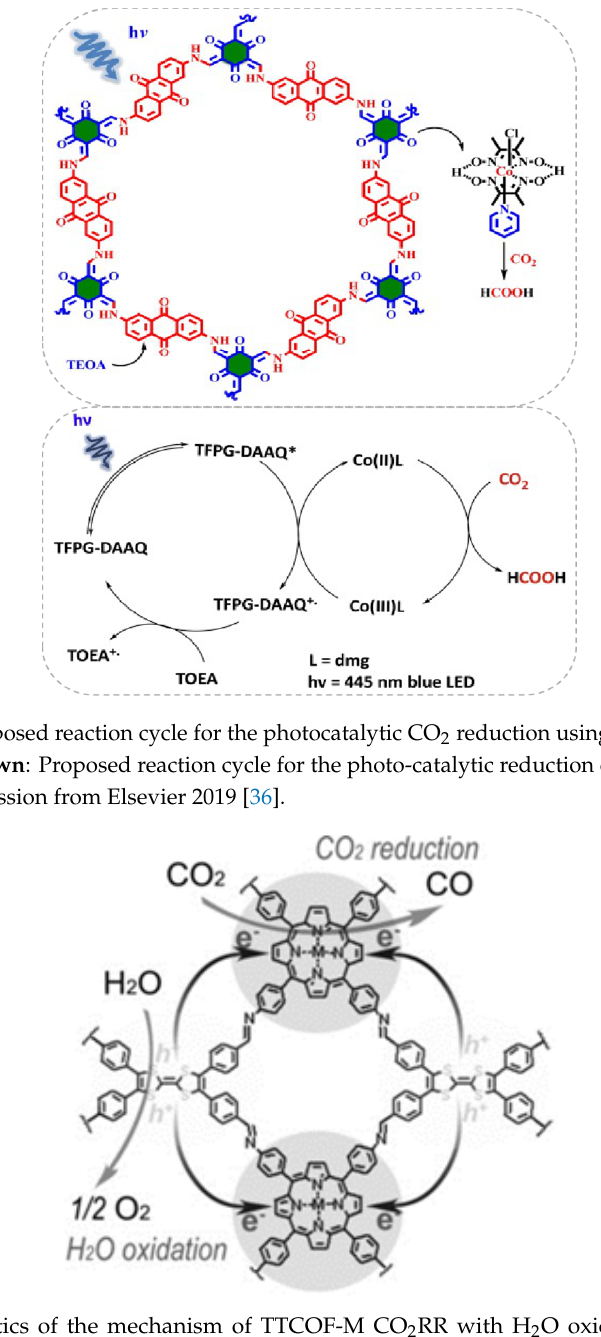
Figure 8. Schematics of the mechanism of TTCOF-M CO 2 RR with H 2 O oxidation. Copied with permission from Wiley 2019 [37].